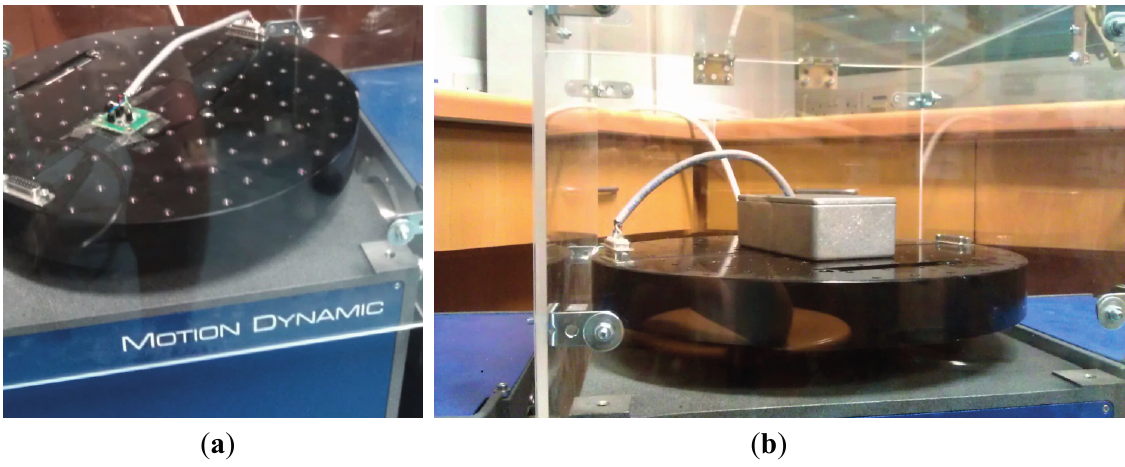
Figure 8. Test setup for characterization of the proposed angular rate sensor. ( a ) the PCB with the sensor is mounted on top of the rate-table; ( b ) the PCB with the sensor is placed in an aluminum box and mounted on top of the rate-table. The aluminum box ensures electromagnetic shielding of the device under test so as to avoid picking up electrical noise emitted from the rate-table